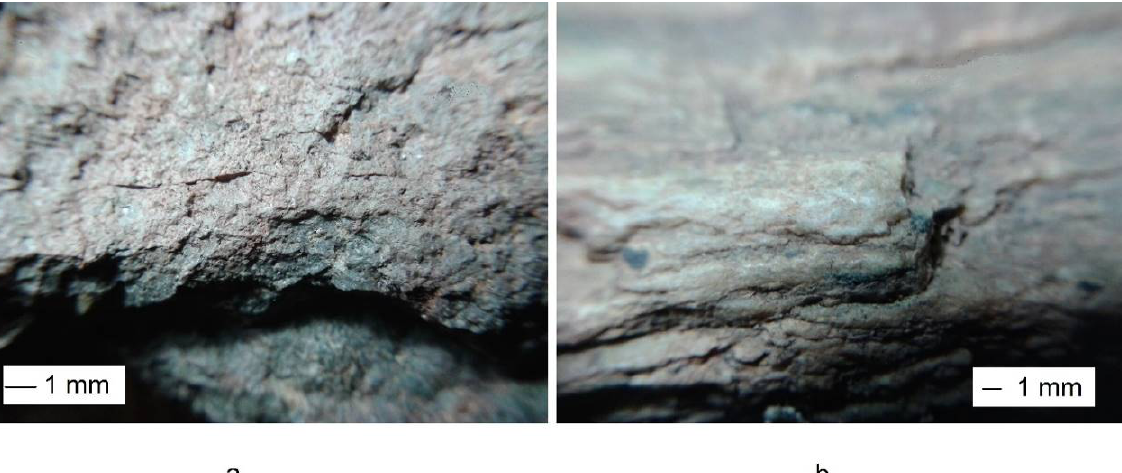
Figure 4. (a) Specimen 7, a shallow secondary macro-flake step-fracture scar on the face; (b) Specimen 14, smoothed and rounded flake scar ridges. (Photographs by Steve Tomka.)